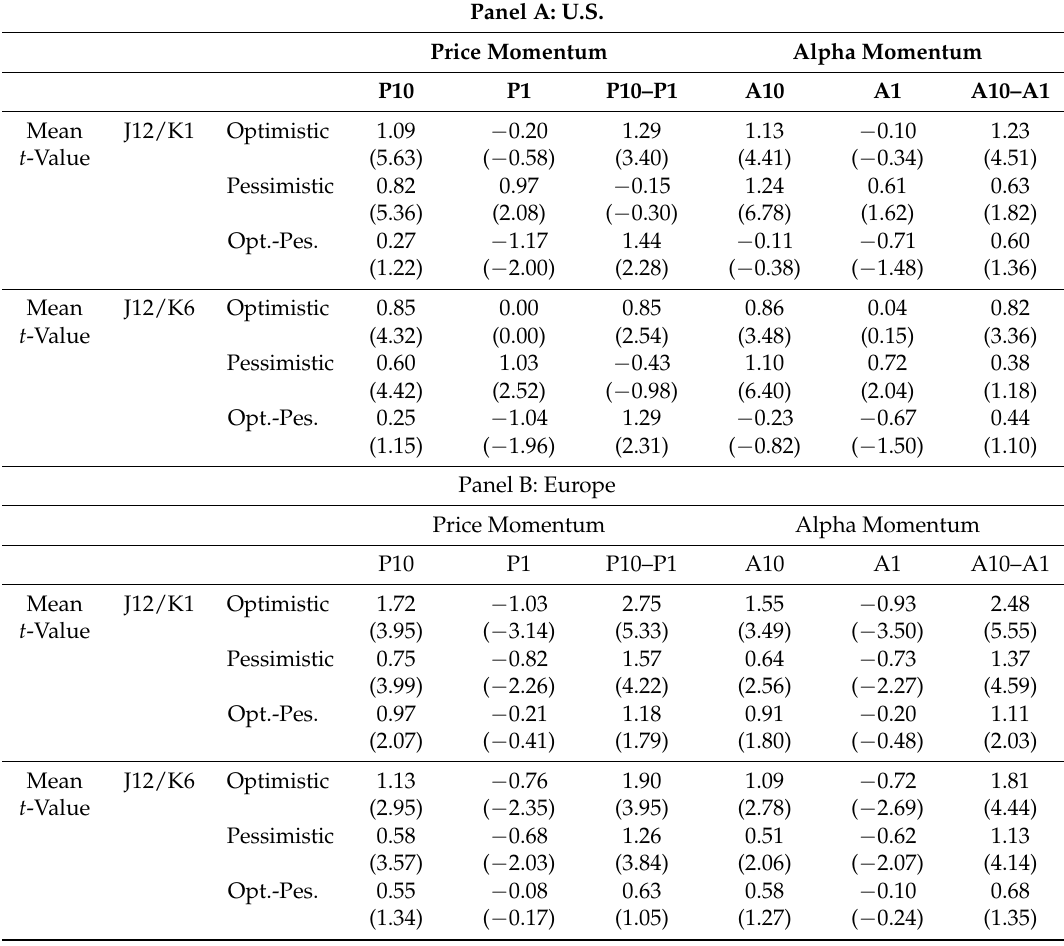
Table 7. Monthly risk-adjusted returns of momentum strategies and sentiment. Panel A: